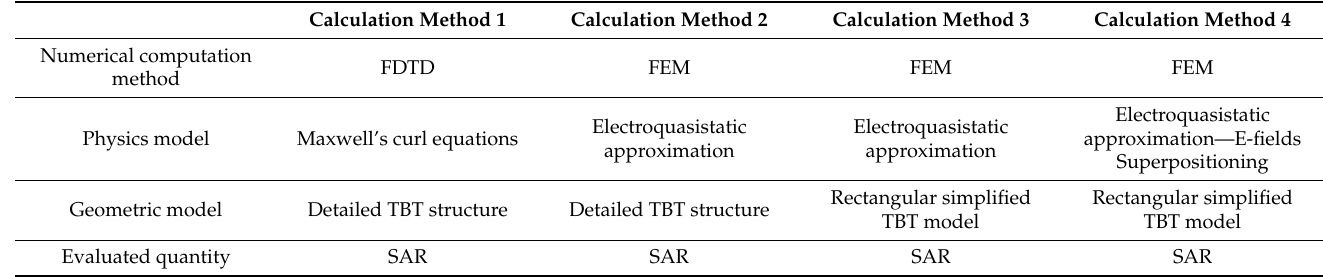
Table 2. Overview of calculation methods evaluated with the benchmarking